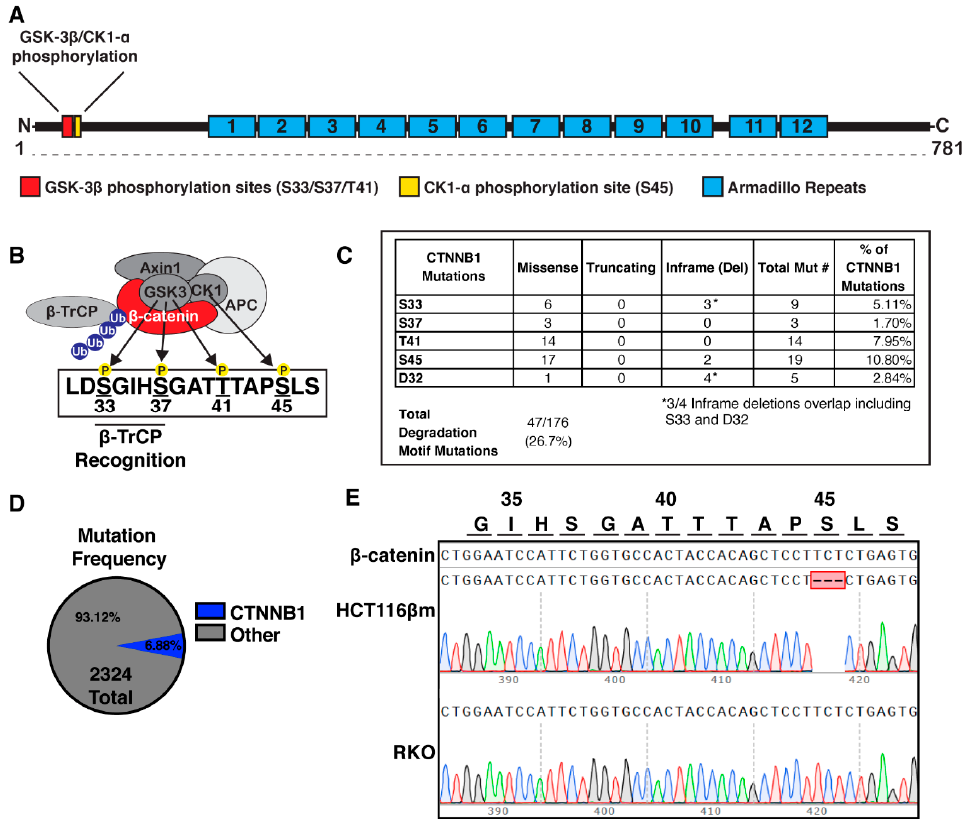
Figure 1. β -catenin phospho-regulation by the β -catenin destruction complex. ( A ) Diagram of β -catenin structure, indicating the N-terminal GSK-3 β phosphorylation sites (Ser33/Ser37/T41), the CK1- α phosphorylation site (Ser45), and the 12 armadillo repeats. ( B ) Schematic of the β -catenin destruction complex composed of Axin, Adenomatous Polyposis Coli (APC), GSK-3 β , and CK1- α , which bind and phosphorylate β -catenin at Ser45, Thr41, Ser37, and Ser33. Phosphorylation at Ser33/Ser37 creates a β -TrCP recognition site. ( C ) Mutation frequency of destruction complex phosphorylation sites among CTNNB1 mutations. ( D ) Mutation frequency of CTNNB1 among 2324 colorectal cancer patients using cBioPortal. ( E ) Sanger sequencing and alignment of CTNNB1 around the destruction complex phosphorylation sites in HCT116 β m and RKO colon cancer cell lines. Mutations in the tumor suppressor Adenomatous Polyposis Coli ( APC ) occur early in the development of over 80% of CRCs. The vast majority of APC mutations lead to the expression of truncated APC protein that retains some ability to interact with and regulate β -catenin. The “just right” model rationalizes the limited range of APC truncations observed in CRCs as facilitating a precise level of β -catenin for optimal cellular proliferation—not too much or too little [19]. In addition For example, APC can interact with nuclear β -catenin, leading to repression of Wnt target genes